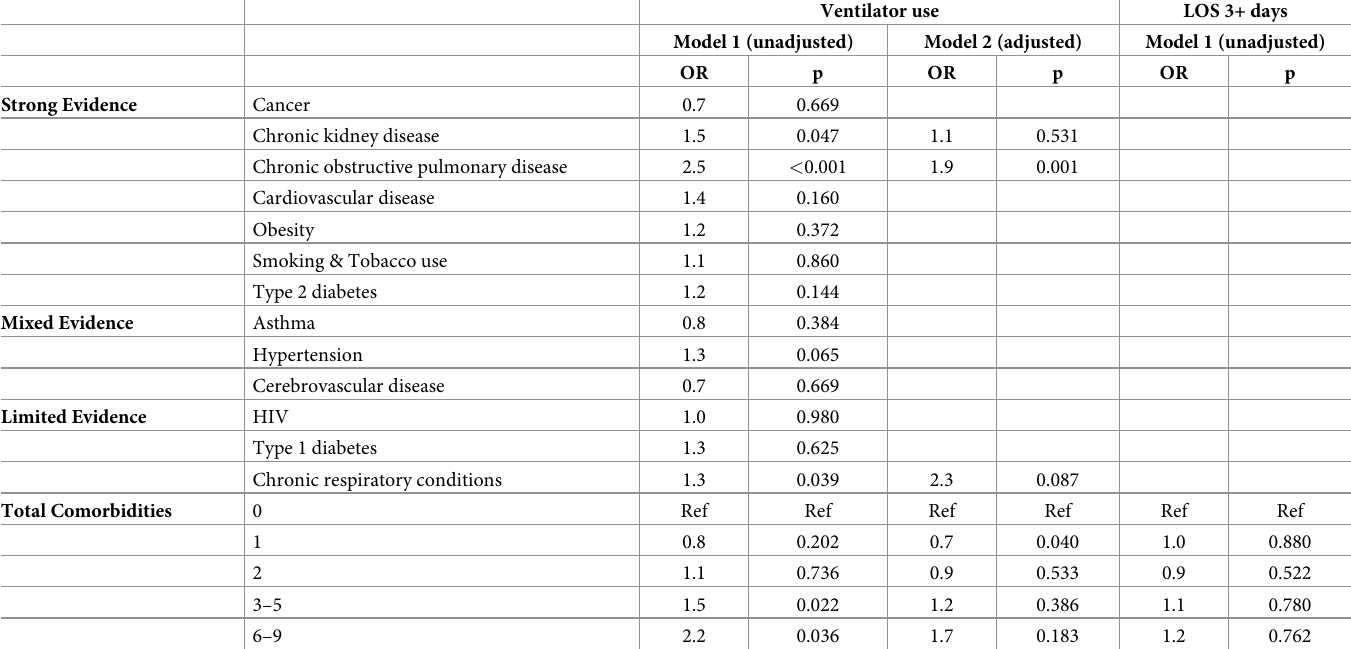
Table 3. Multivariate logistic regression odds ratios and p-values for ventilator use and length of stay 3+